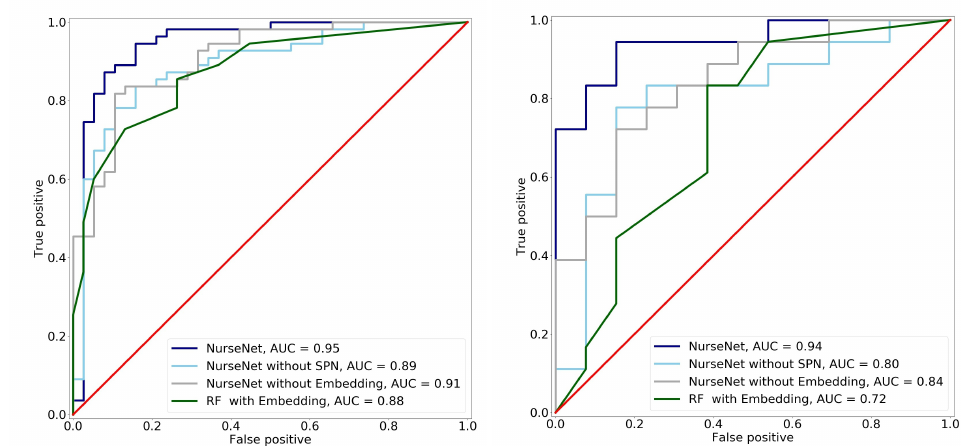
Figure 12. ROC obtained when classifying staff/elderly activities using the different variants of N URSE N ET and RF on ( left ) the entire dataset and ( right ) the test set. The corresponding AUCs are displayed in the figure legend. Note that N URSE N ET outperformed all the other algorithms in both cases. It also generalized well, as it had consistent performances between the test set and the entire dataset, contrary to the